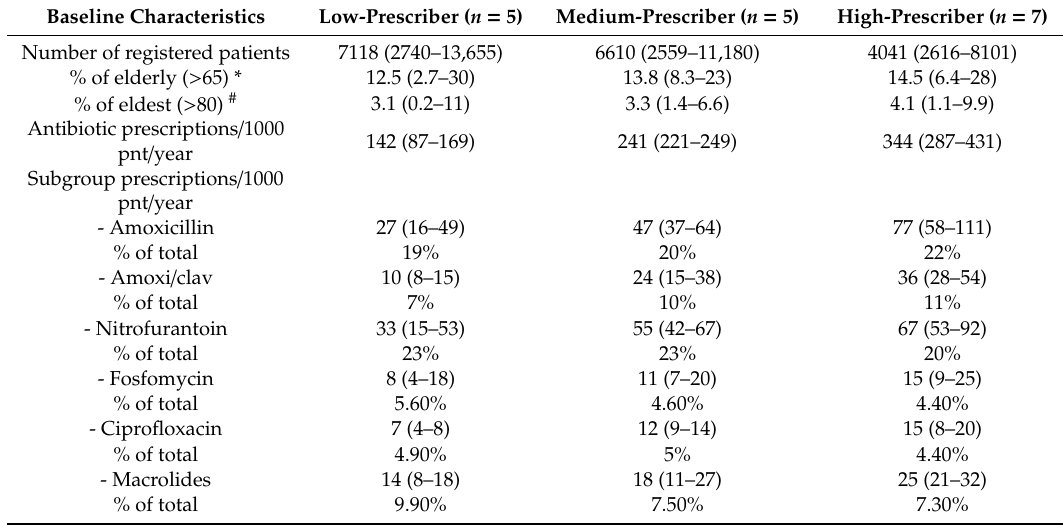
Table 1. Baseline characteristics of the 17 primary care practices split per prescriber